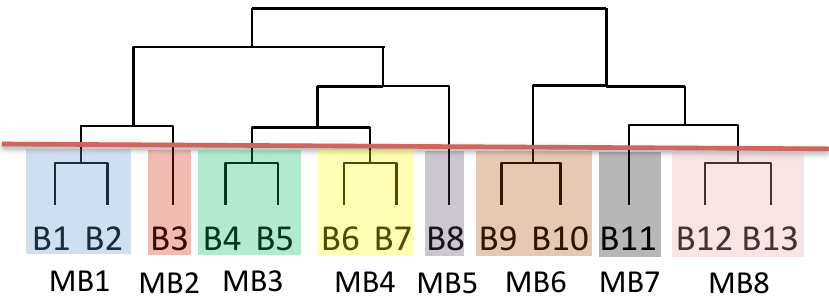
Figure 3: Meta-biclusters represented as clusters of biclusters in the